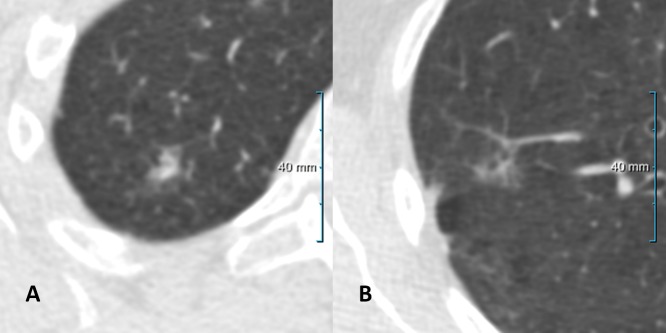
(a) A transient lesion with disagreement (2 versus 2) among observers. (b) A persistent lesion with disagreement (2 versus 2) among observers.